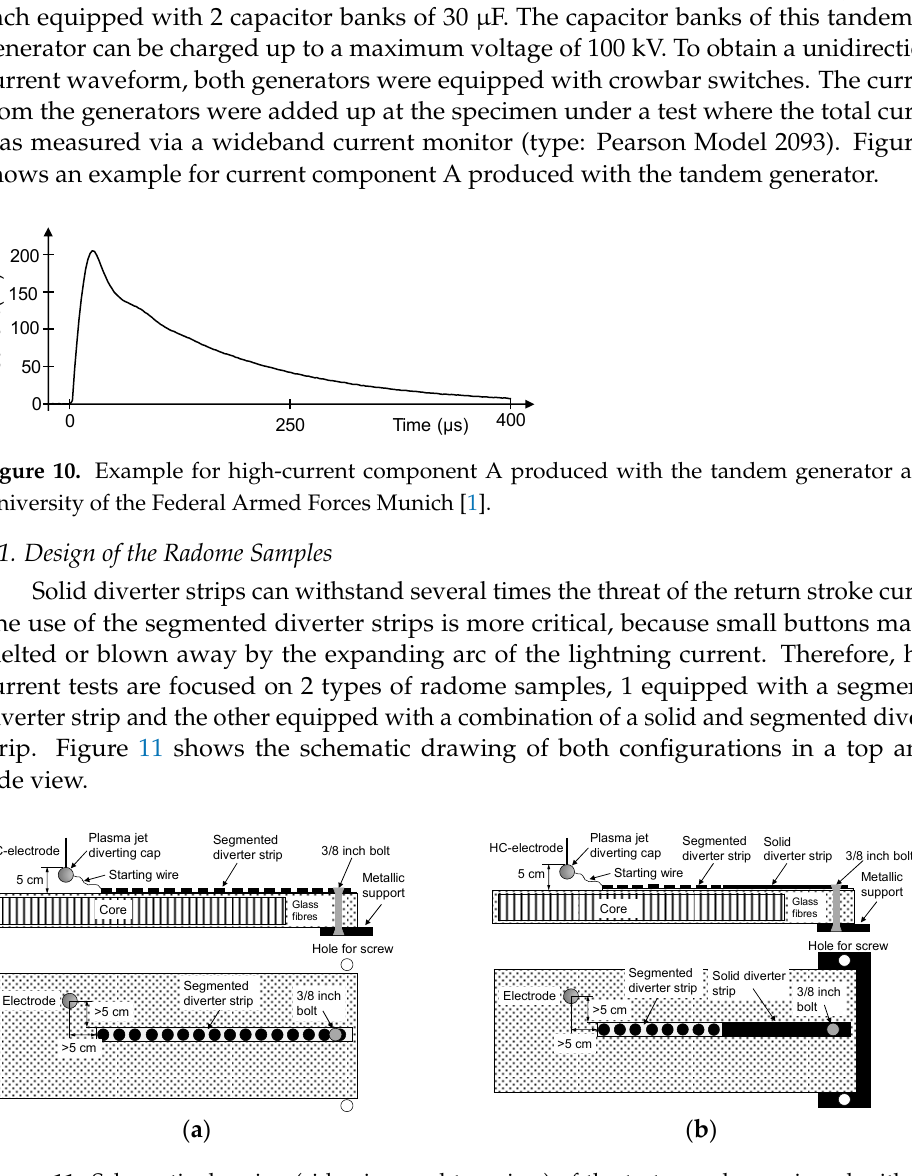
Figure 11. Schematic drawing (side view and top view) of the test samples equipped with ( a ) a segmented diverter strip (configuration 1), and ( b ) a combination of solid and segmented diverter strips (configuration 2).